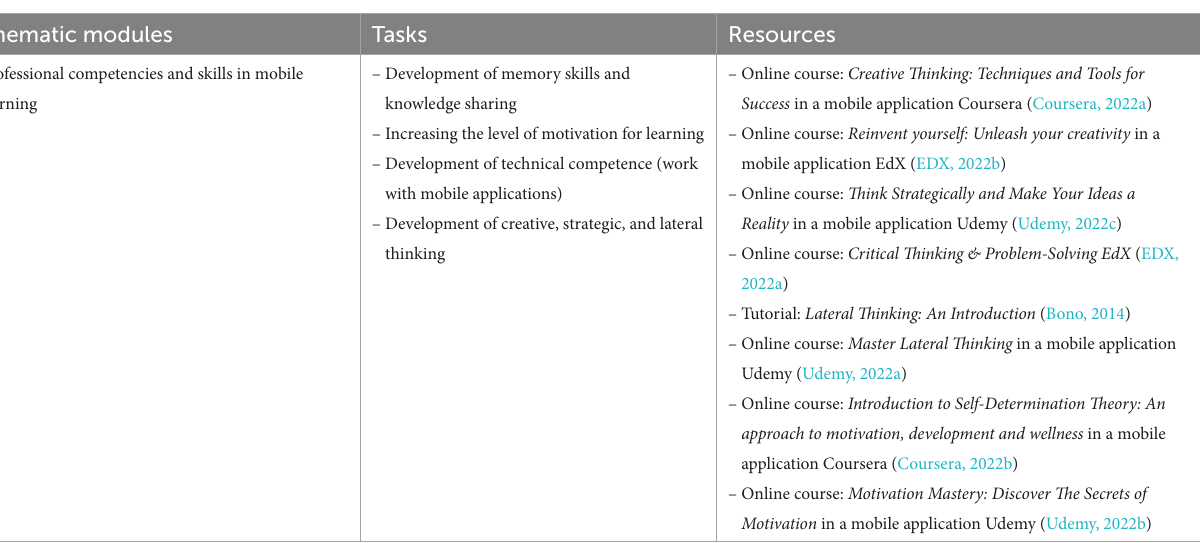
TABLE 1 Content of the training